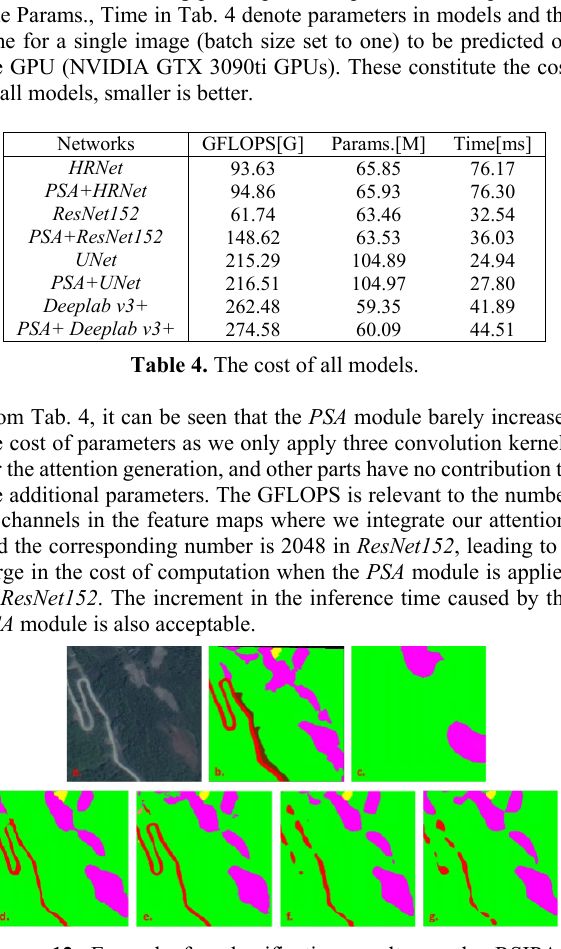
Figure 12. Example for classification results on the RSIPAC dataset, the image marked with a is the input image, and b , c , d , e , f , g , denote the ground truth label, result of the baseline ( ResNet152 ), and corresponding results applied with PSA, LKPP, SENet, Non-local , respectively. Corresponding colors for land cover classes are listed in Tab. 3.